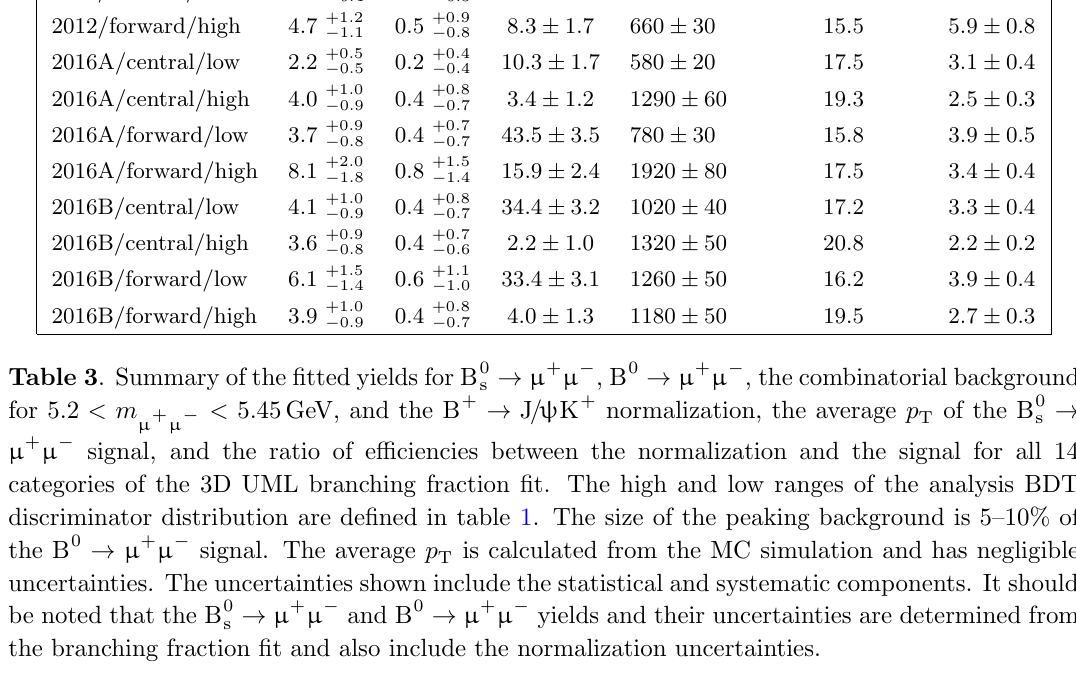
categories of the 3D UML branching fraction (cid:12)t. The high and low ranges of the analysis BDT